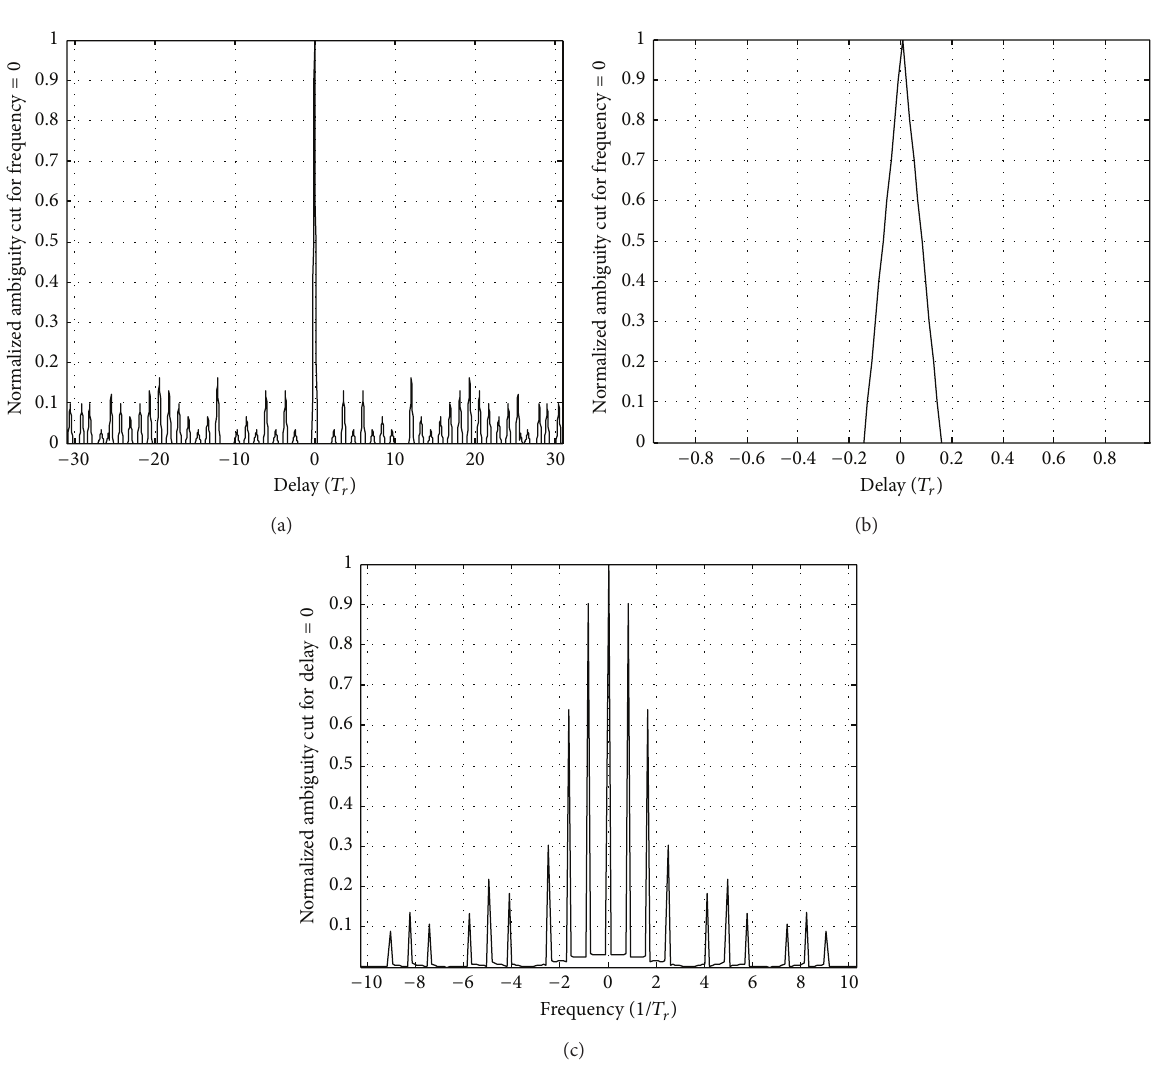
Figure 10: The ranging and velocity ambiguity function for 𝑁 𝑝 = 31 and 𝑇 𝑟 = 4𝑡 𝑝 .